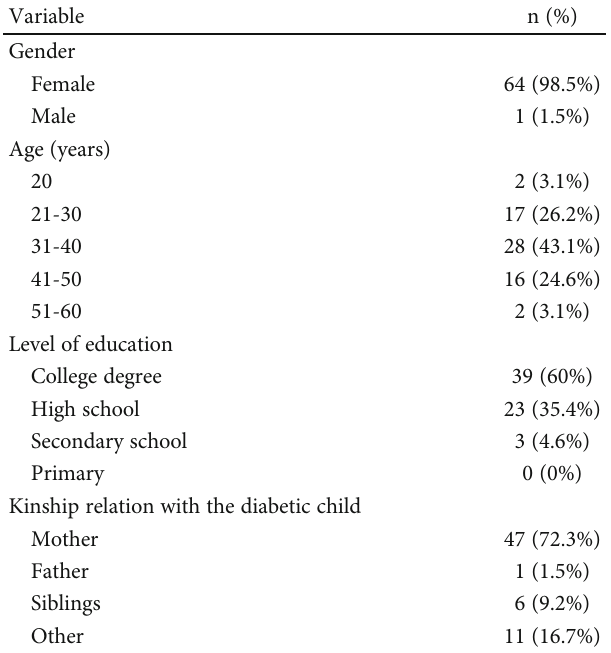
Table 1: Demographic information of caregivers ( n = 65 ).